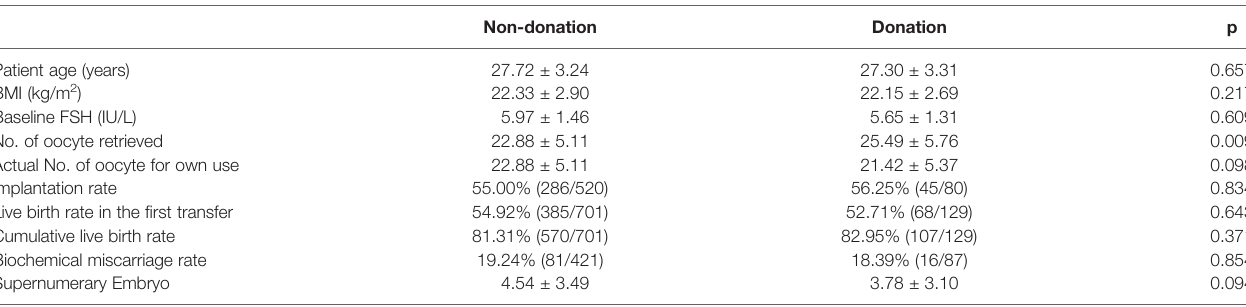
TABLE 1 | Basic characteristics of two groups.